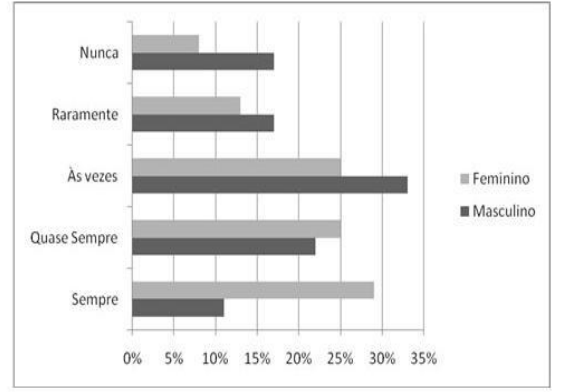
Figura 2. Com que os participantes costumam dançar nas festas. A somatória é maior do que 100% pela possibilidade de assinalar mais de uma